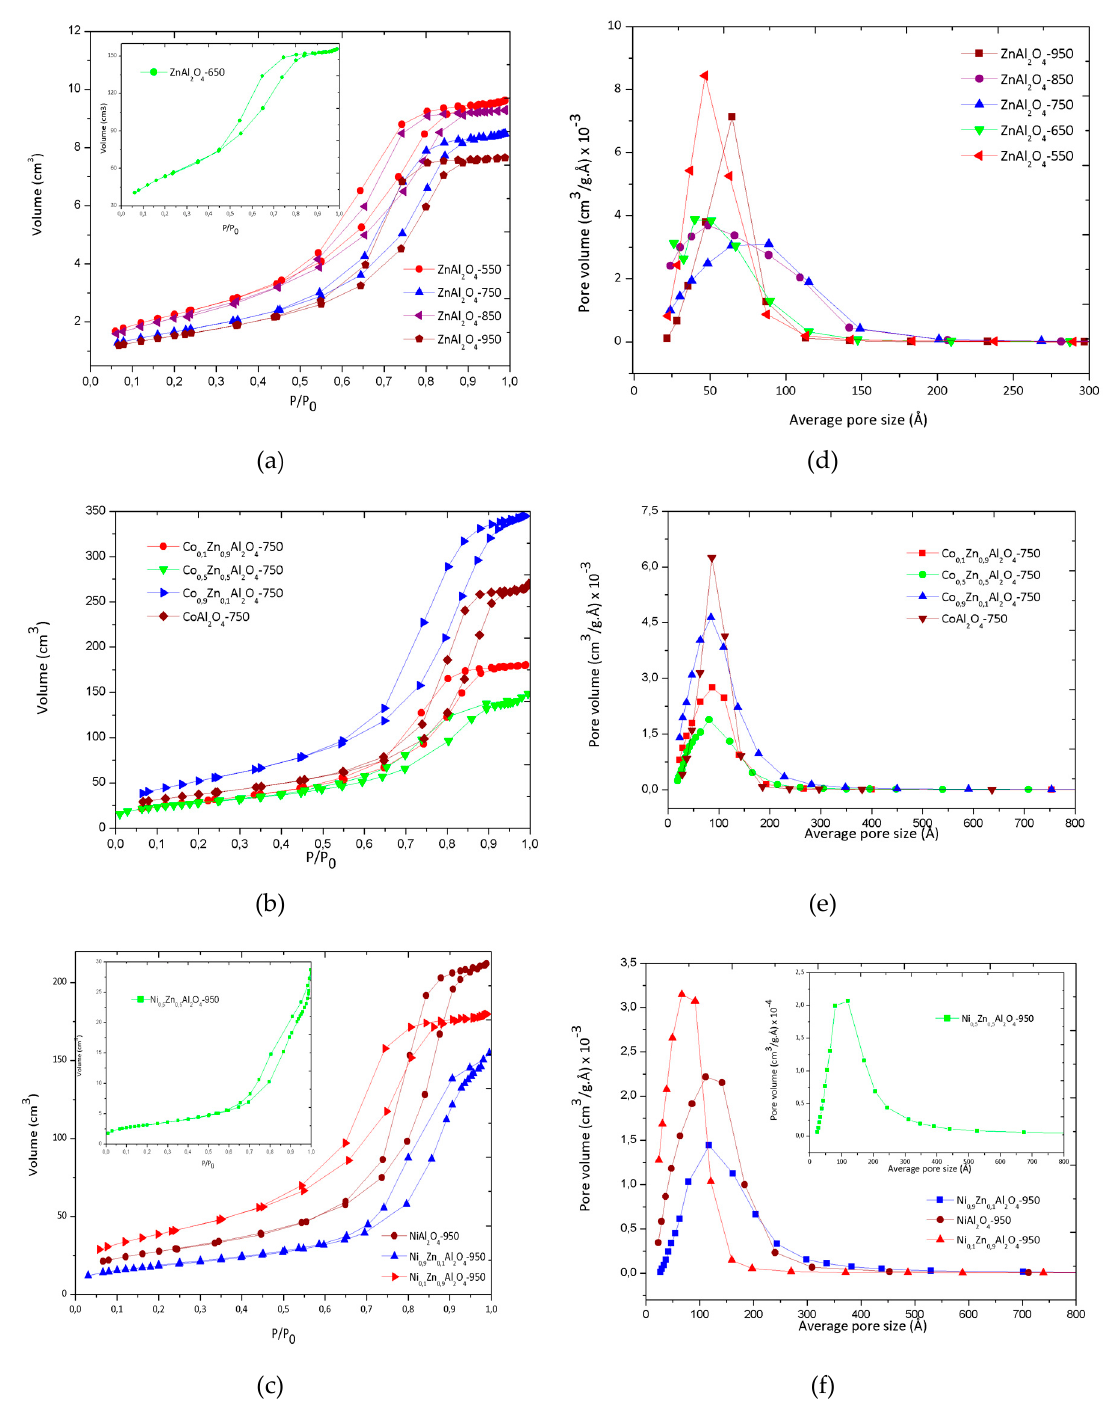
Figure 5. N 2 adsorption-desorption isotherms and average pore size distribution. N 2 adsorption- desorption isotherms for: ( a ) ZnAl 2 O 4 samples, ( b ) samples replaced by cobalt ions. ( c ) samples replaced by nickel ions. Average pore size distribution for: ( d ) ZnAl 2 O 4 samples, ( e ) samples replaced by cobalt ions, ( f ) samples replaced by nickel ions.